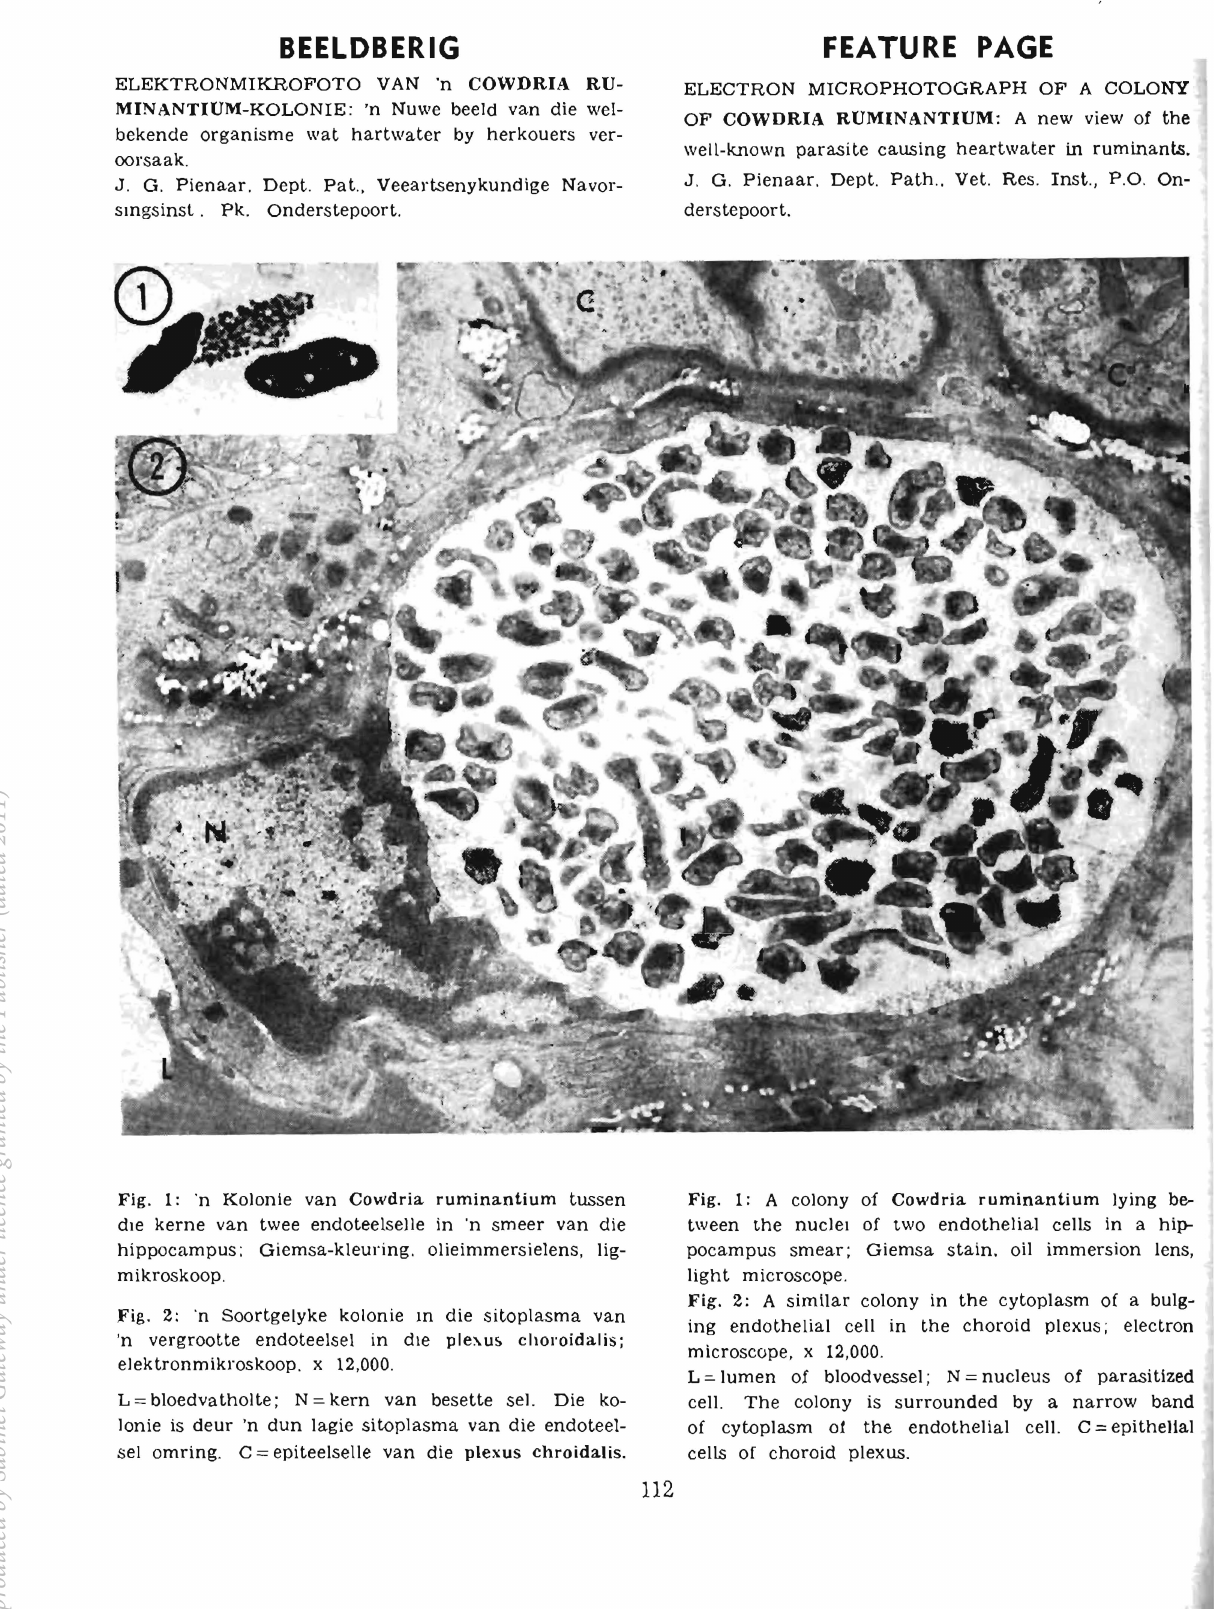
Fig. 1: A colony of Cowdria ruminantium lying be tween the nuclei of two endothelial cells in a hip pocampus smear; Giemsa stain, oil immersion lens, light microscope. Fig. 2: A similar colony in the cytoplasm of a bulg ing endothelial cell in the choroid plexus; electron microscope, x 12,000. L ~ lumen of blood vessel ; N = nucleus of parasitized cell. The colony is surrounded by a narrow band of cytoplasm 01 the endothelial cell. C = epithelial cells of choroid 112